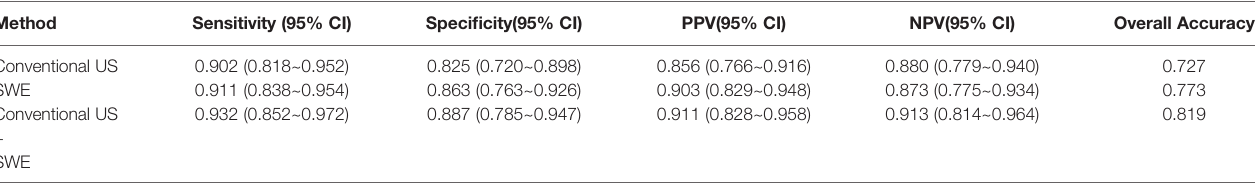
TABLE 3 | Diagnostic performance of Conventional US, SWE, and Conventional US combined